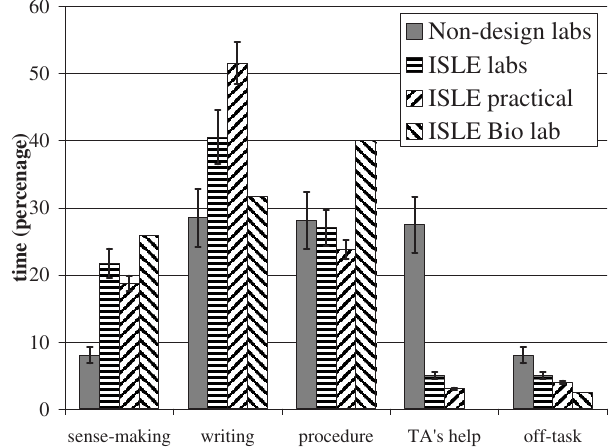
FIG. 2. Percentage of time spent on different activities. The data are averaged over the sample. The error bars show the standard deviations of the data sets for the observed